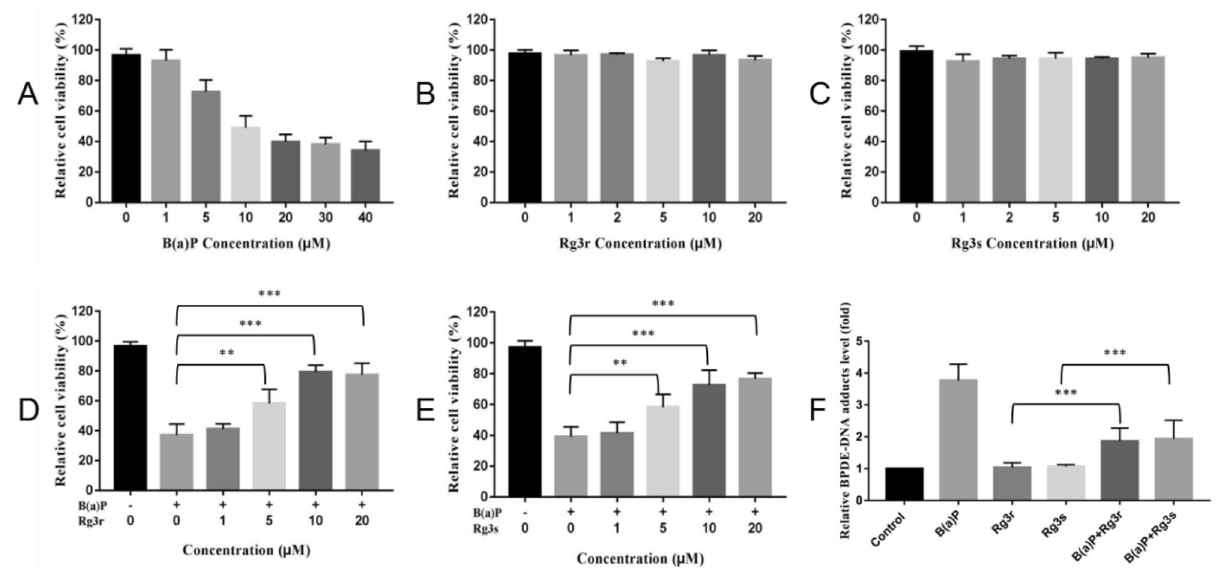
Figure 5. Cell viability and BPDE-DNA adduct formation in hEL cells treated with G-Rg3 and B(a)P. ( A ) Cell viability of hEL cells treated with B(a)P. ( B ) Cell viability of hEL cells treated with G-Rg3r. ( C ) Cell viability of hEL cells treated with G-Rg3s. ( D ) Cell viability of hEL cells treated with B(a)P and G-Rg3r. ( E ) Cell viability of hEL cells treated with B(a)P and G-Rg3s. ( F ) BPDE-DNA adduct levels of hEL cells treated with B(a)P and G-Rg3. The data is presented as the mean ± SD of triplicate assays. * P < 0.05, ** P < 0.01, *** P <